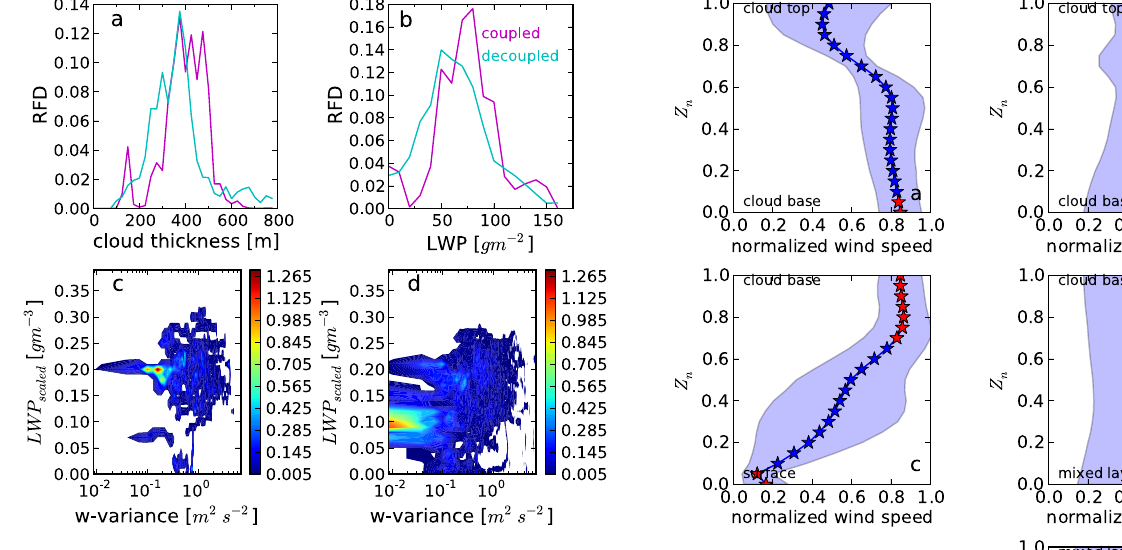
Fig. 12. Relative frequency distributions (RFDs) of (a) cloud thick- Figure 12. Relative frequency distributions (RFDs) of a) cloud thickness [m] and ness [m] and cloud LWP [gm − 2 ] for coupled (magenta) and de- cloud LWP [g m -2 ] for coupled (magenta) and decoupled (cyan) surface-cloud coupled (cyan) surface–cloud coupling states during 25–30 August. coupling states during 25-30 August. 2-D RFD histogram (contours) relationships Two-dimensional RFD histogram (contours) relationships between between cloud layer scaled LWP [g m -3 ] (see text for description) and w-variance in cloud-layer scaled LWP [gm − 3 ] (see text for description) and w variance in the 5–10min frequency range at cloud mid-level for (c) the 5-10 min frequency range at cloud mid-level for c) coupled and d) decoupled coupled and (d) decoupled states. states.